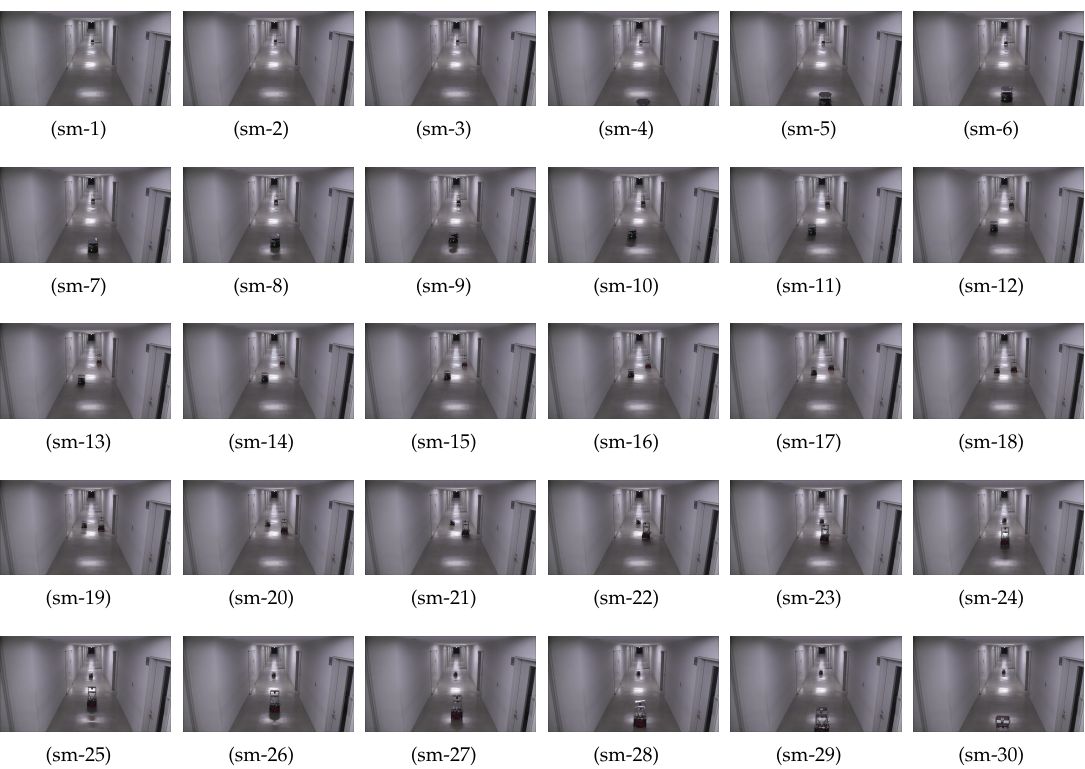
Figure Action Description Figure 19(sm-1) ∼ (sm-7) Move Straight Robots navigate towards each other Figure 19(sm-8) ∼ (sm-11) Smooth Turn Left Both the robots smoothly move to left Figure 19(sm-12) ∼ (sm-20) Crossover Robots cross each other Figure 19(sm-21) ∼ (sm-24) Smooth Turn Right Both the robots smoothly approach corridor’s center Figure 19(sm-25) ∼ (sm-30) Move Straight Robot navigate towards their